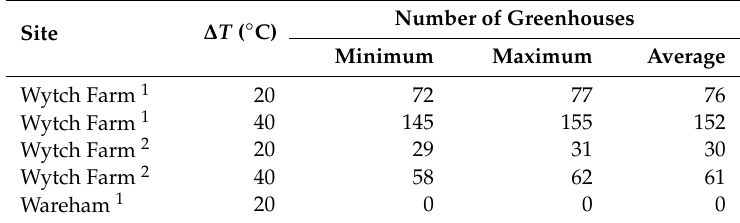
Table 6. Numbers of 595 kW